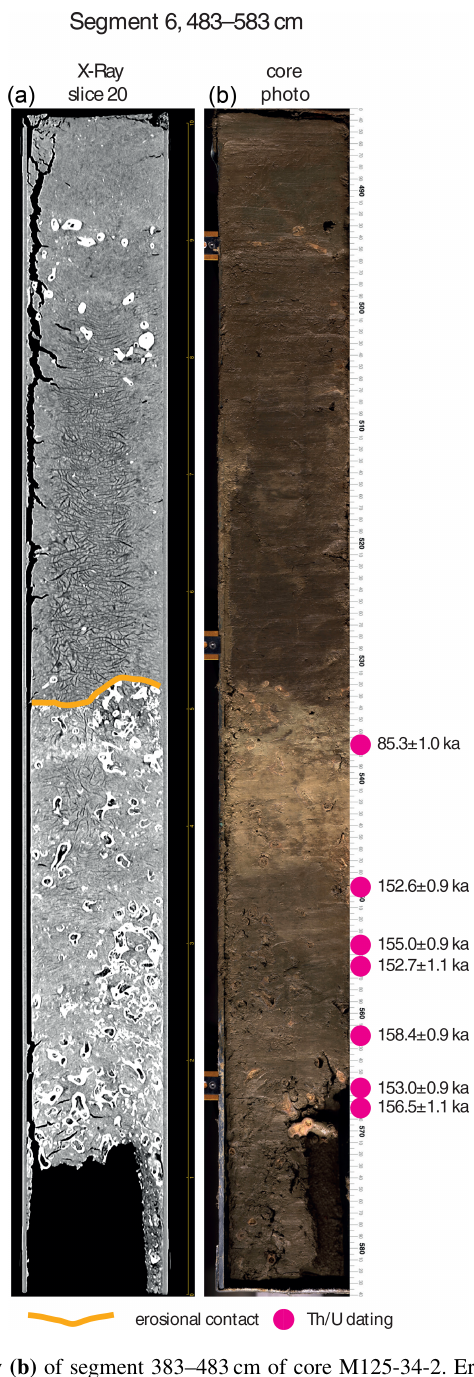
Figure F1. CT image (a) and photography (b) of segment 383–483cm of core M125-34-2. Erosional contacts are marked by thick black lines; positions of Th / U datings with calibrated age are indicated by magenta dots.